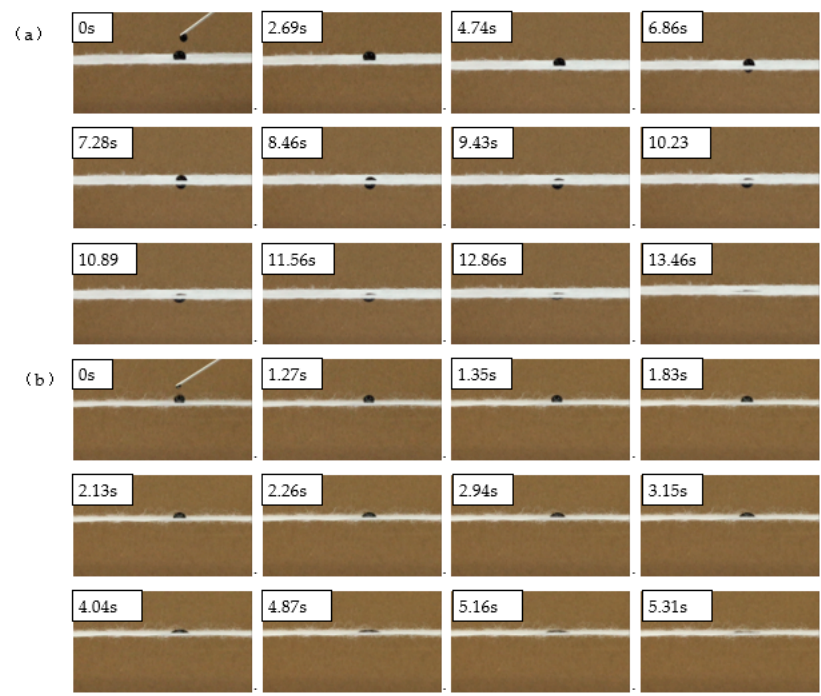
Figure 11. Practical effect of the unidirectional liquid transportation of AgNO 3 -PS/PET membrane: ( a ) the transportation of the drop on the hydrophobic AgNO 3 -PS layer; ( b ) the transportation of the drop on the hydrophilic PET layer.